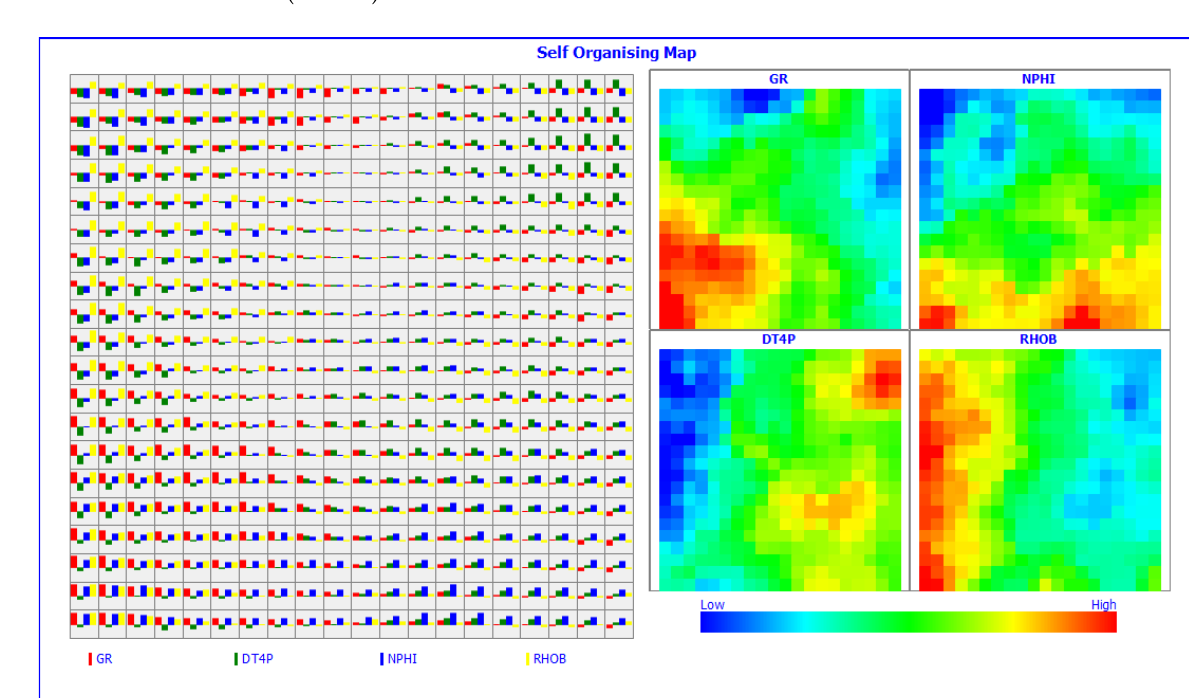
Figure 4. Self-organising map before calibration.